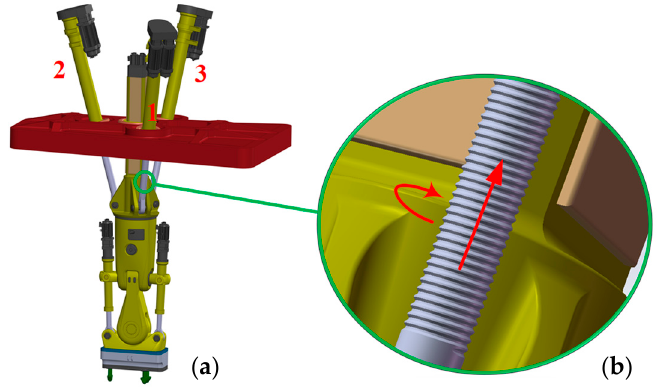
Figure 8. HKM prototype ( a ); piston thread drive mechanism ( b ).